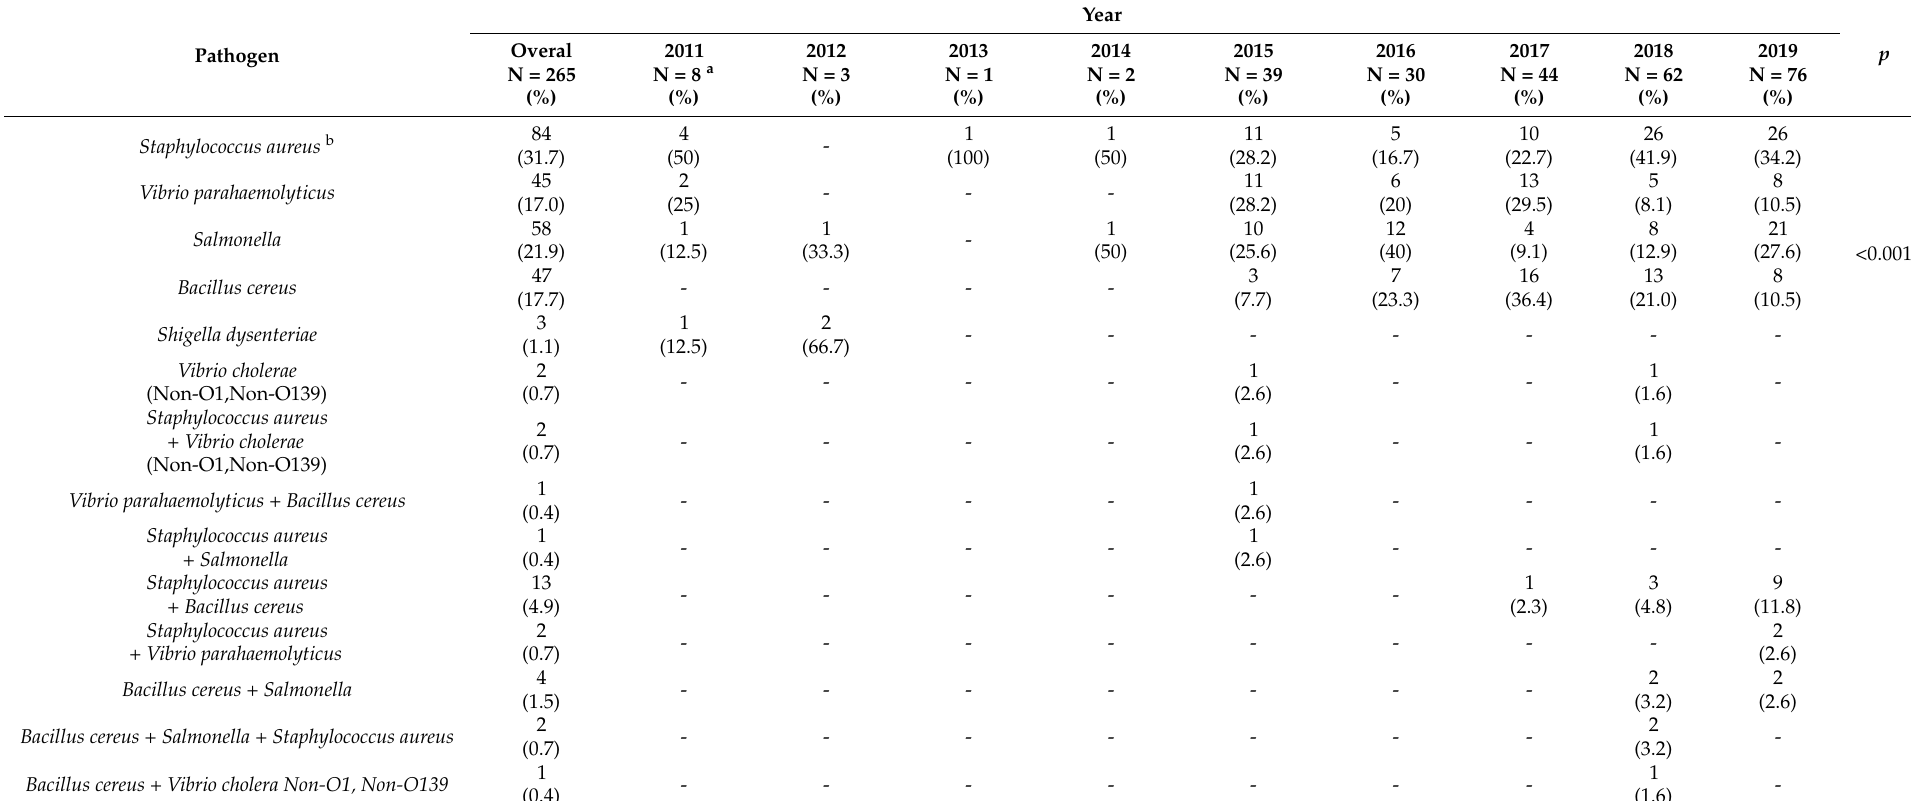
Table 3. Bacteria and other pathogens causing diarrhea clusters in Taiwan,